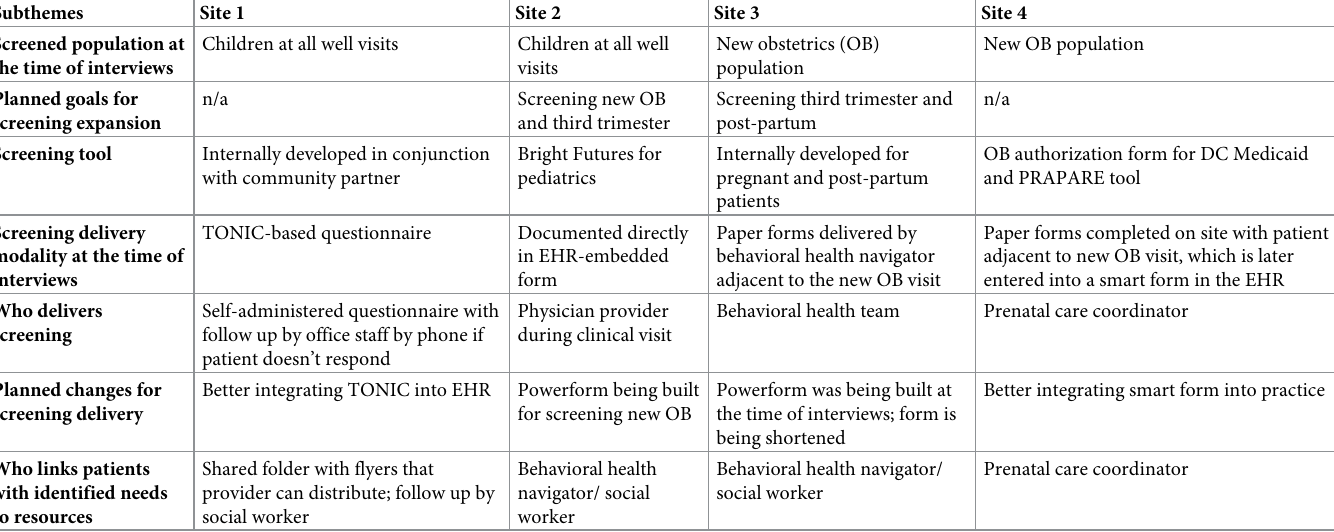
Table 2. Comparison of screening and referral across included